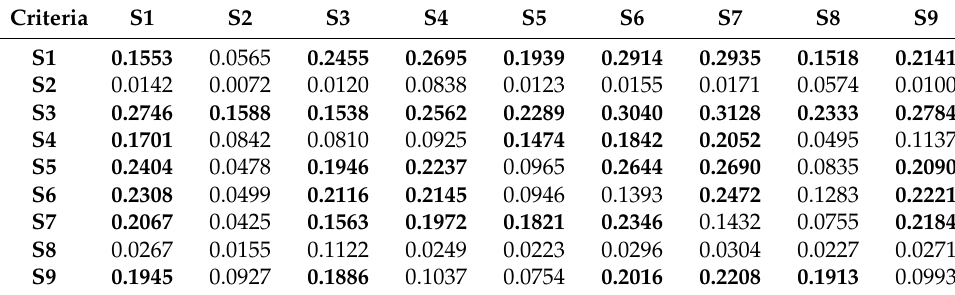
Table 4. The total-relation matrix.